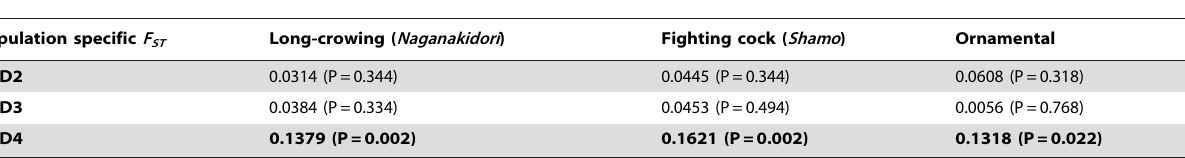
Table 1. The population-specific F ST values of three chicken groups.